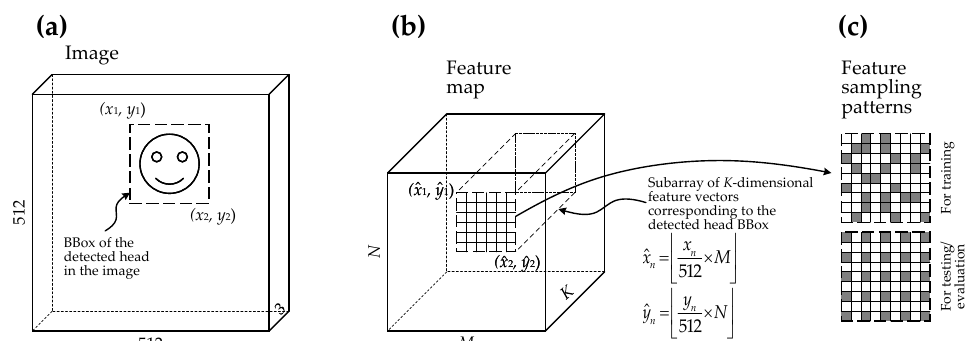
Figure 3. A diagram explaining the sampling process of features for image quality (motion blur level) evaluation that is based on the LightGBM ranker model. At first, a subarray of K -dimensional feature vectors (part of the feature map) ( b ) corresponding to the detected head BBox in the input image ( a ) is determined. The said region of the feature map describes the image patch containing the face. The spatial position of the region in the feature map ( b ) is relatively the same (proportional) as the position of the head’s bounding box (BBox) in the image ( a ). Later, only part of the feature vectors from the region are selected ( c ): feature vectors randomly sampled for the training dataset and uniformly sampled for